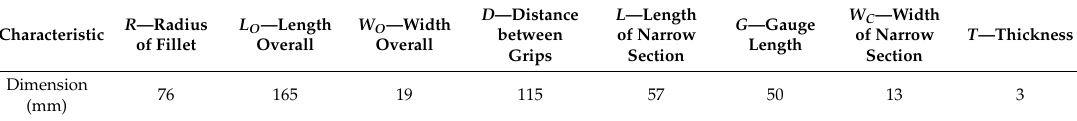
Figure 1. Schematic diagram of tensile specimens for the epoxy resin, R : radius of fillet; L O : length overall; W O : width overall; D : distance between grips; L : length of narrow section; G : gauge length; W C : width of narrow section; T : thickness. Table 1. Details of the tensile specimens for the epoxy resin.